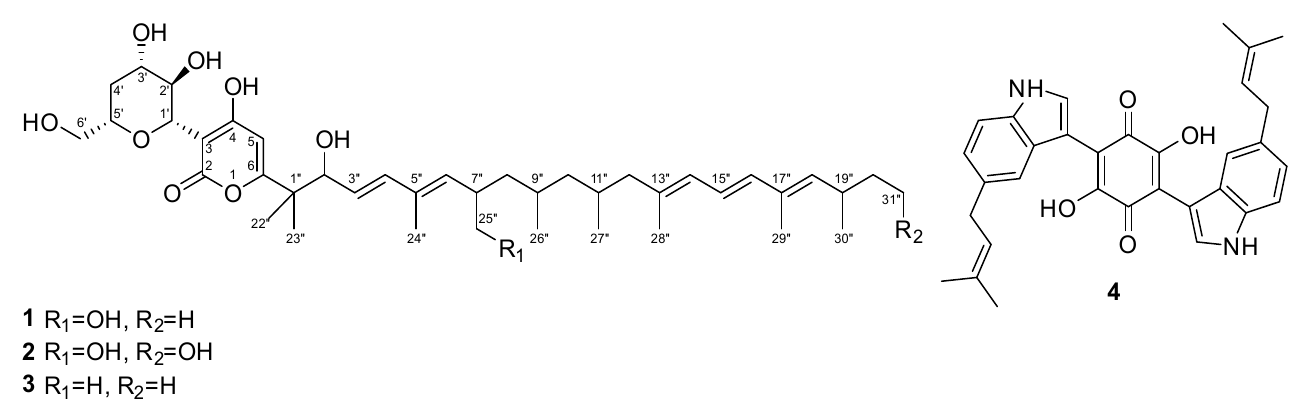
Figure 3. Chemical structures of the isolated metabolites ( 1 – 4 ). Compound 1 was obtained as a colorless amorphous powder and its molecular formula was established as C 41 H 64 O 9 (ten degrees of unsaturation) according to the quasimolecular ion peak cluster at m / z 701.46257 [M + H] + in the HRESI-MS spectrum. Comparison 1 H and 13 C NMR data of 1 measured in DMSO- d 6 with those of Xaio et al. [46] confirmed its identity as dactylfungin A, a known antifungal antibiotic containing an α -pyrone ring conjoined with a polyalcohol moiety and a long side chain. An MS/MS similarity search in MetaboScape for dactylfungin A ( 1 ) against all the identified features in the crude extract yielded an MS/MS score > 750 for compounds 2 and 3 , as well as other minor derivatives observed in the dactylfungin molecular family (MF) (Figures 4 and S1–S4). Thus, this MF consisted of 16 consensus spectra (nodes), including compounds 2 and 3 , each of which differed by the addition and loss of one oxygen atom when compared to 1 ; consequently, we embarked on their preparative isolation.